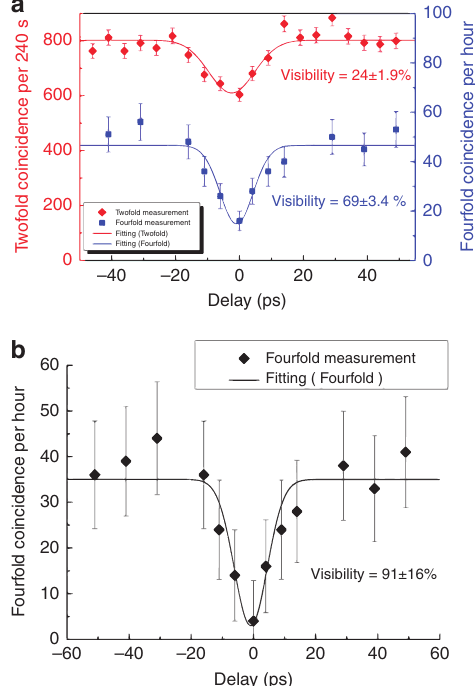
Figure 4 | Indistinguishability measurement of the multiplexed photons. ( a ) Raw visibility of twofold (diamonds, left axis) and fourfold (squares, right axis) measurements. ( b ) Fourfold HOM dip visibility after subtracting multi-photon noise. Poisson error bars are used for the plots. Solid lines are Gaussian fits according to the spectral filtering shape in the